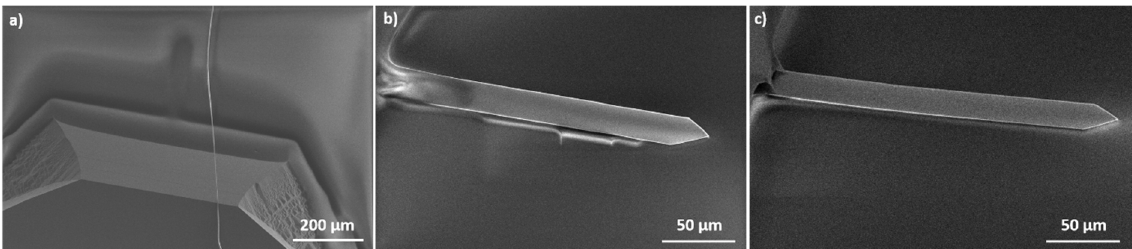
Figure 4. SEM ( a ) top view and ( b , c ) titled view of cantilevers deposited in the resin. The resin was spin coated at different rotation speeds: (a) 1000 rpm, (b) 2000 rpm and (c) 2250 rpm.